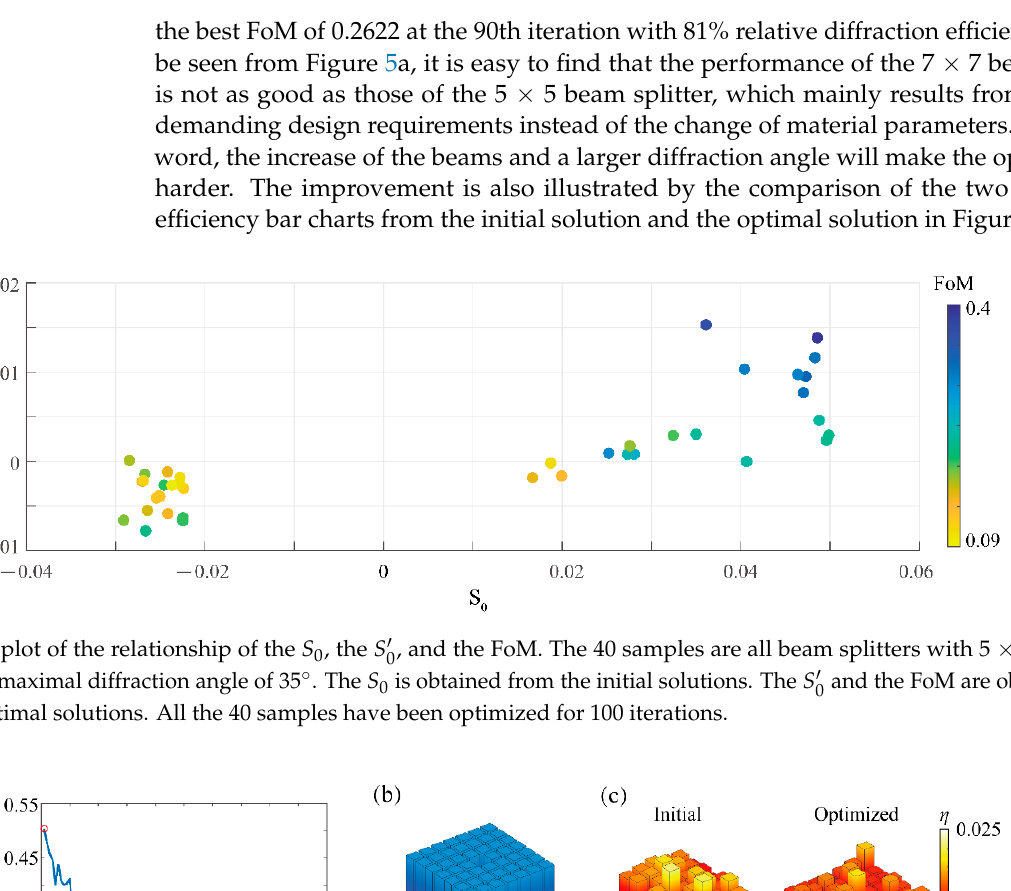
Figure 5. ( a ) FoM as a function of the iteration in the optimization process for the 7 × 7 beam splitter with a maximal diffraction angle of ±70°, which is measured from the (±3, ±3)th order to the (0,0)th order. The iteration where the initial solution and the optimal solution are obtained are marked by red circles. ( b ) The amplitude coefficient of the scalar solution that is used for vector IFTA. It has a suppressed (0,0)th order. ( c ) The comparison of the initial solution’s and the optimal solution’s energy distribution of diffraction orders.